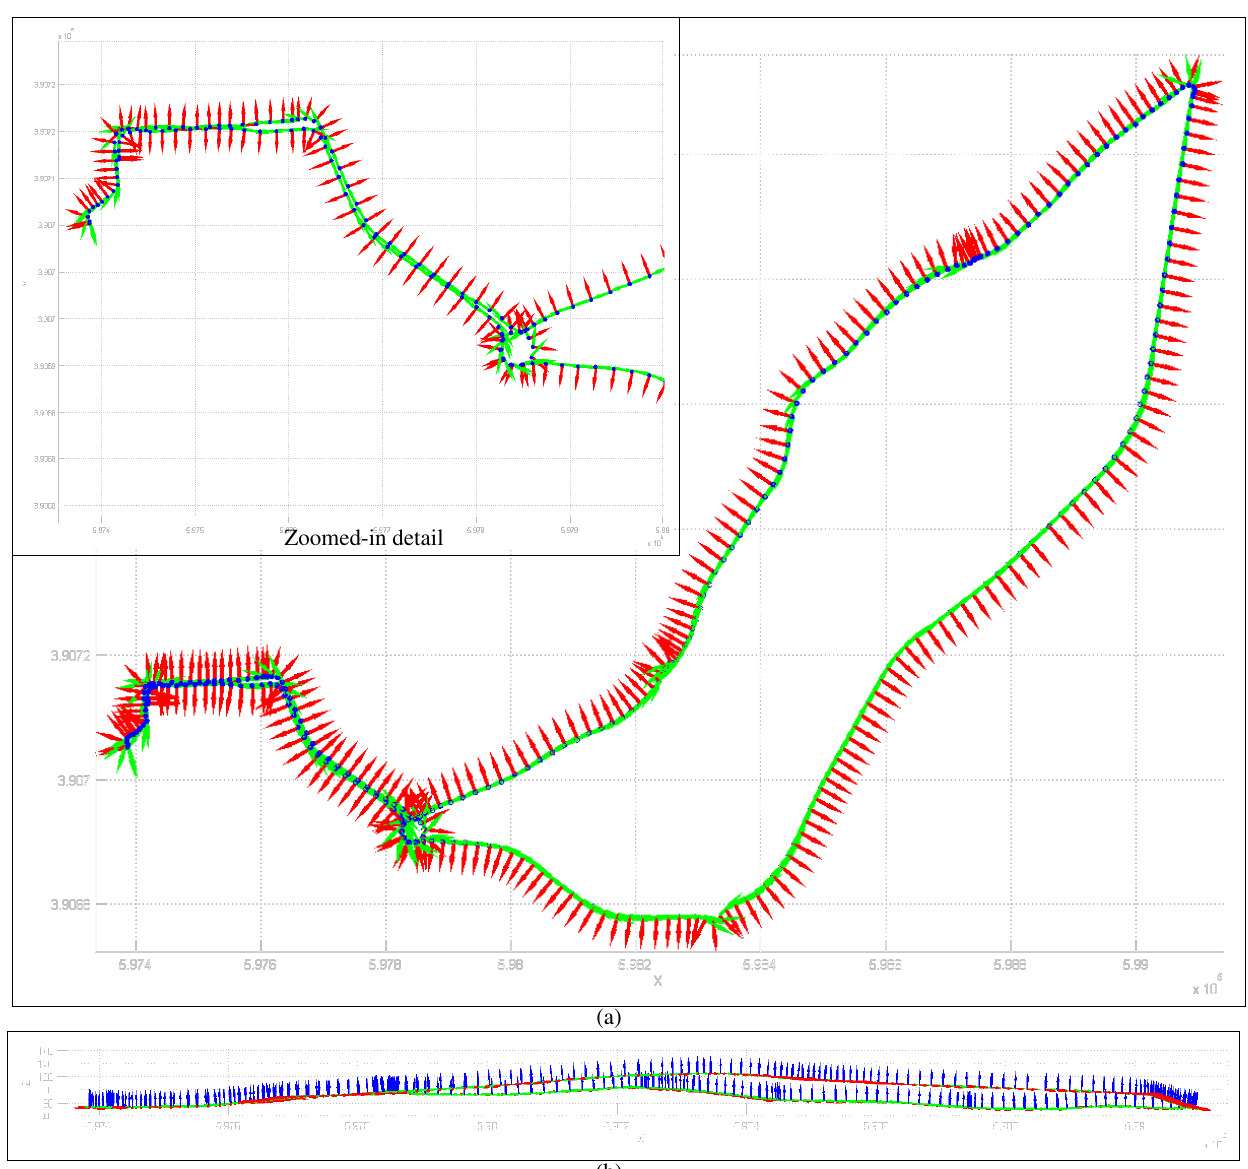
Figure 2. Moving trihedrals for the 3D poses estimated for the route of Figure 1. A top view of the x, y plane is in (a) and a side view towards the positive y -axis, demonstrating altitude differences, in (b). The inset image in (a) shows its lower left part in more